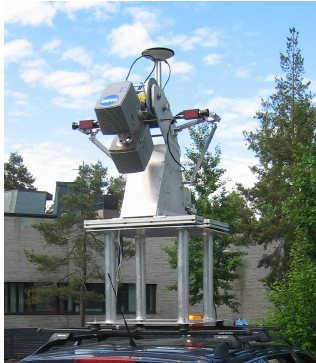
Figure 1. The Roamer system consists of a rigid platform on which a laser scanner and a navigation system are